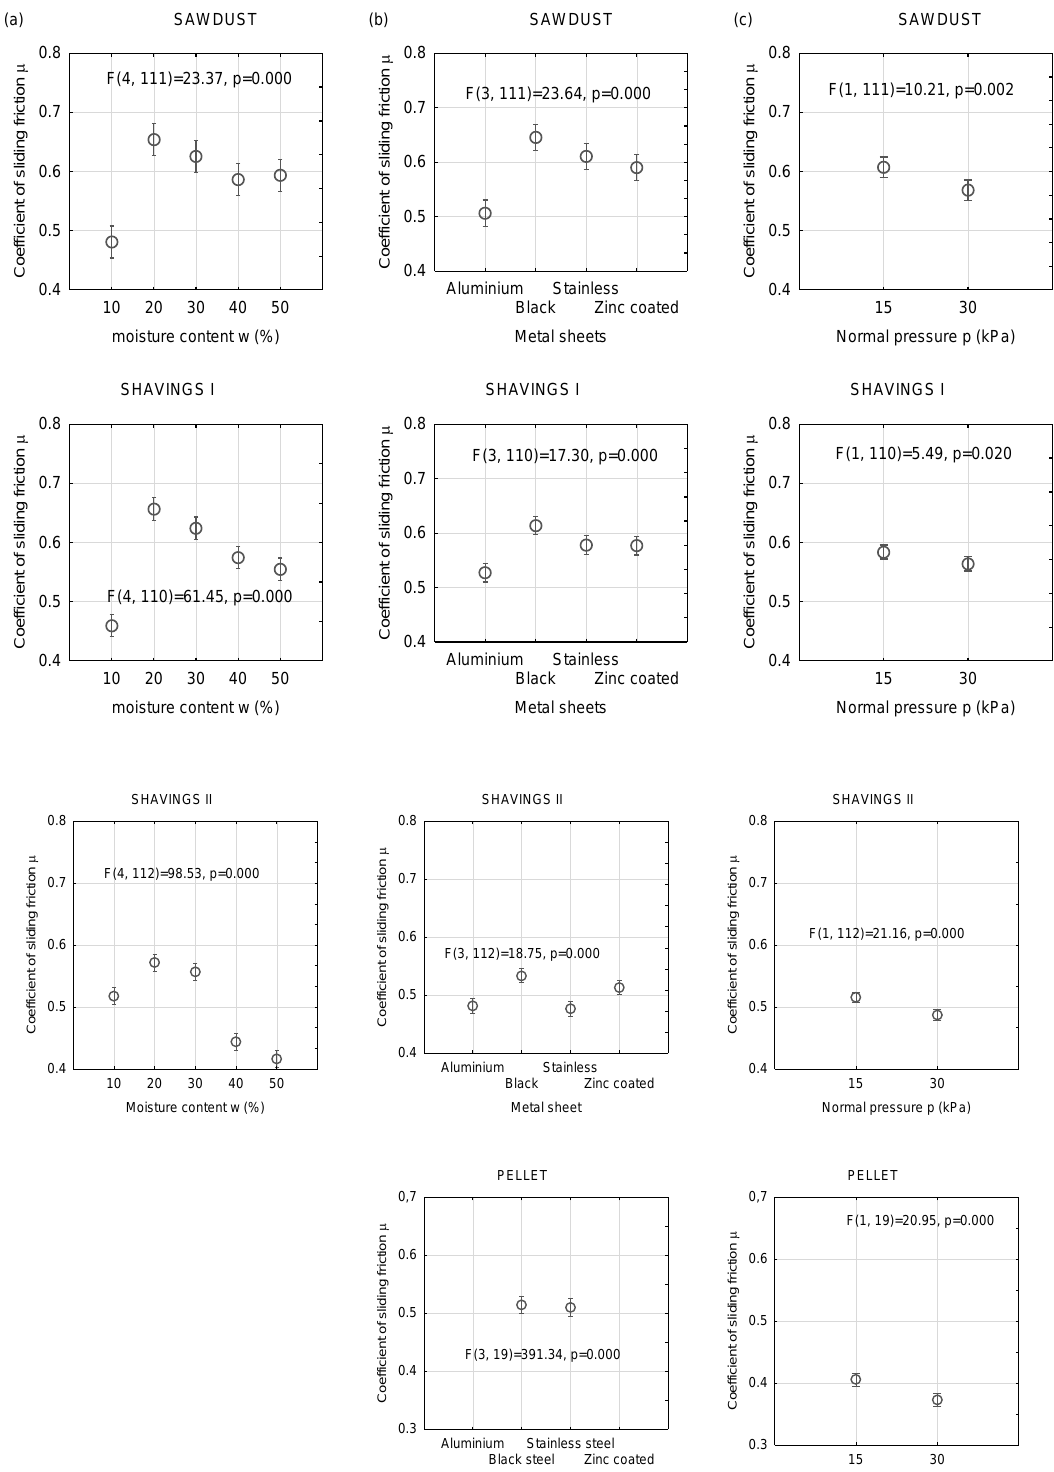
Figure 5. Mean value of sliding friction coefficient with 0.95 confidence intervals for various materials in dependence on moisture content ( a ), kind of sheet material (b) and normal pressure (c).